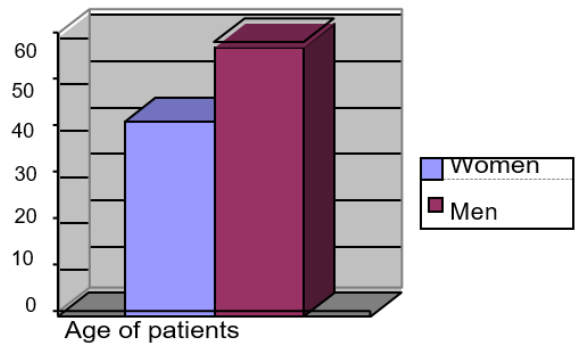
Figure 1. Percentage gender distribution of respondents.